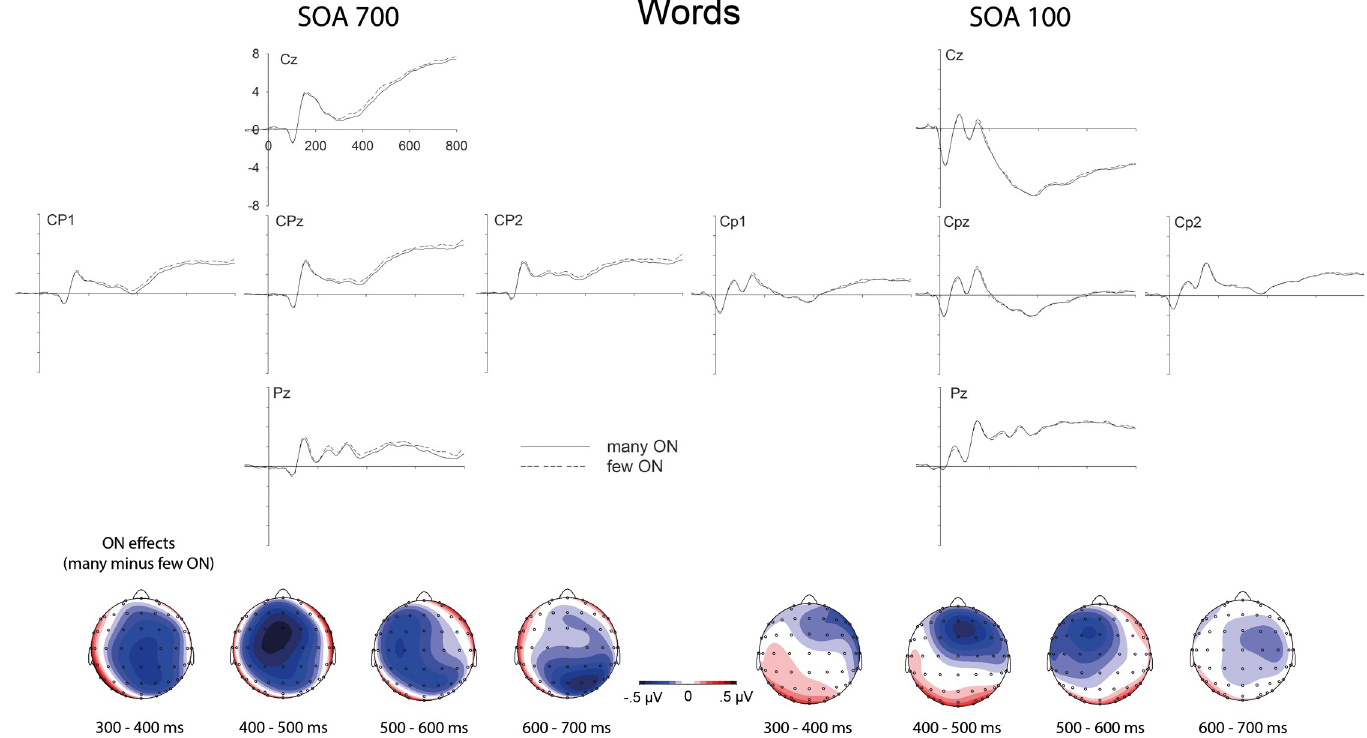
Fig 3. Orthographic neighborhood effects on event-related brain potentials to words. Top. Influences of orthographic neighborhood (ON) size on event-related brain potentials at centro-parietal electrode sites, to the left in conditions of low task overlap (SOA 700) and to the right in conditions of high task overlap (SOA 100). Bottom. Topographical distributions of the above depicted ON effects (many minus few